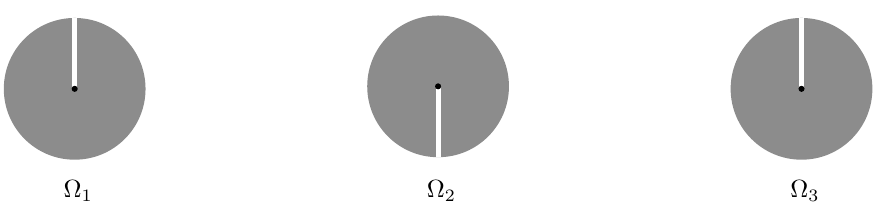
Figure 1. The Stokes sectors (cid:10) n , n = 1 ; 2 ; 3, in the complex t